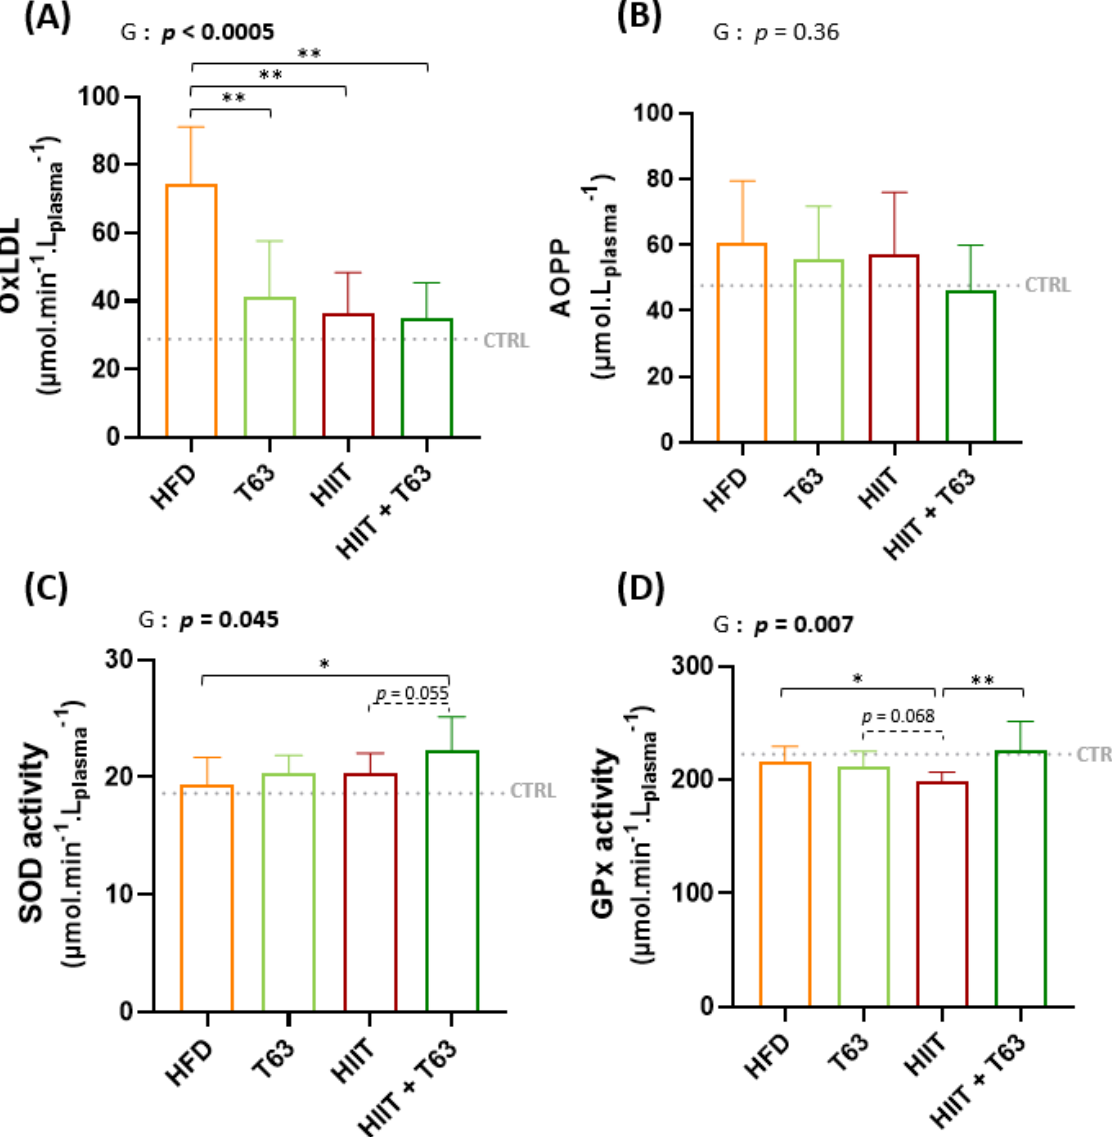
Figure 6. Effects of T63 supplementation and/or HIIT on oxidized low-density lipoproteins (oxLDL) ( A ), advanced oxidation protein products (AOPP) ( B ), superoxide dismutase (SOD) activity ( C ), and glutathione peroxidase (GP X ) activity ( D ) in plasma. * p < 0.05, ** p < 0.005, G: group effect.